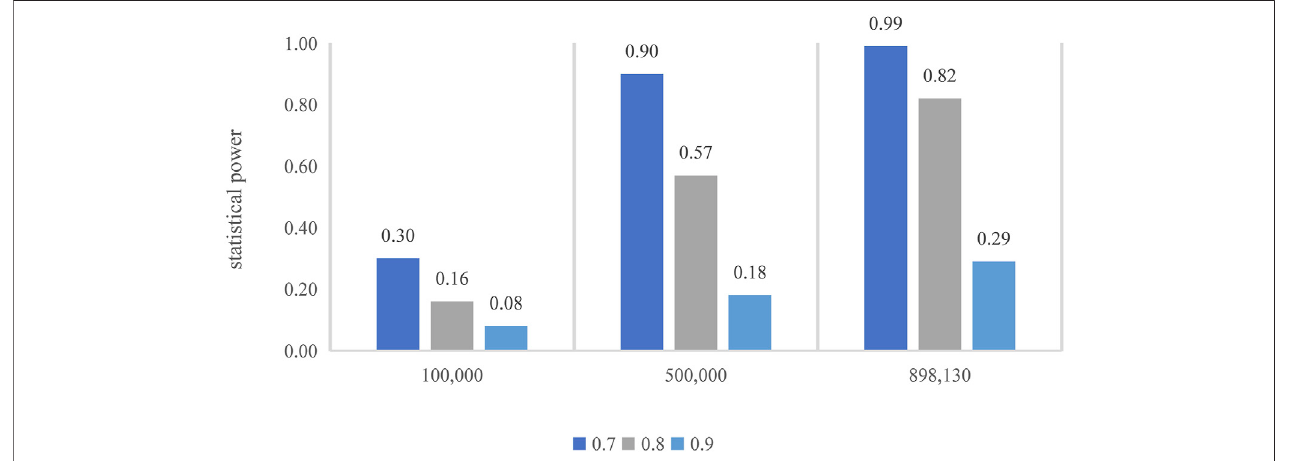
FIGURE 7 | Power calculation for the MR. The top of each bar represents the estimated power, with the x -axis indicating the different sample sizes.